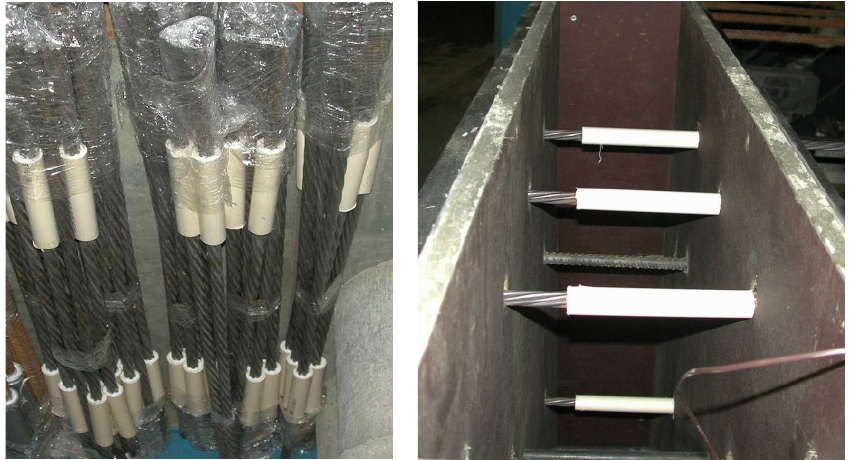
Figure 2. Polyvinyl chloride polymer (PVC) sheathing and installation of prestressing